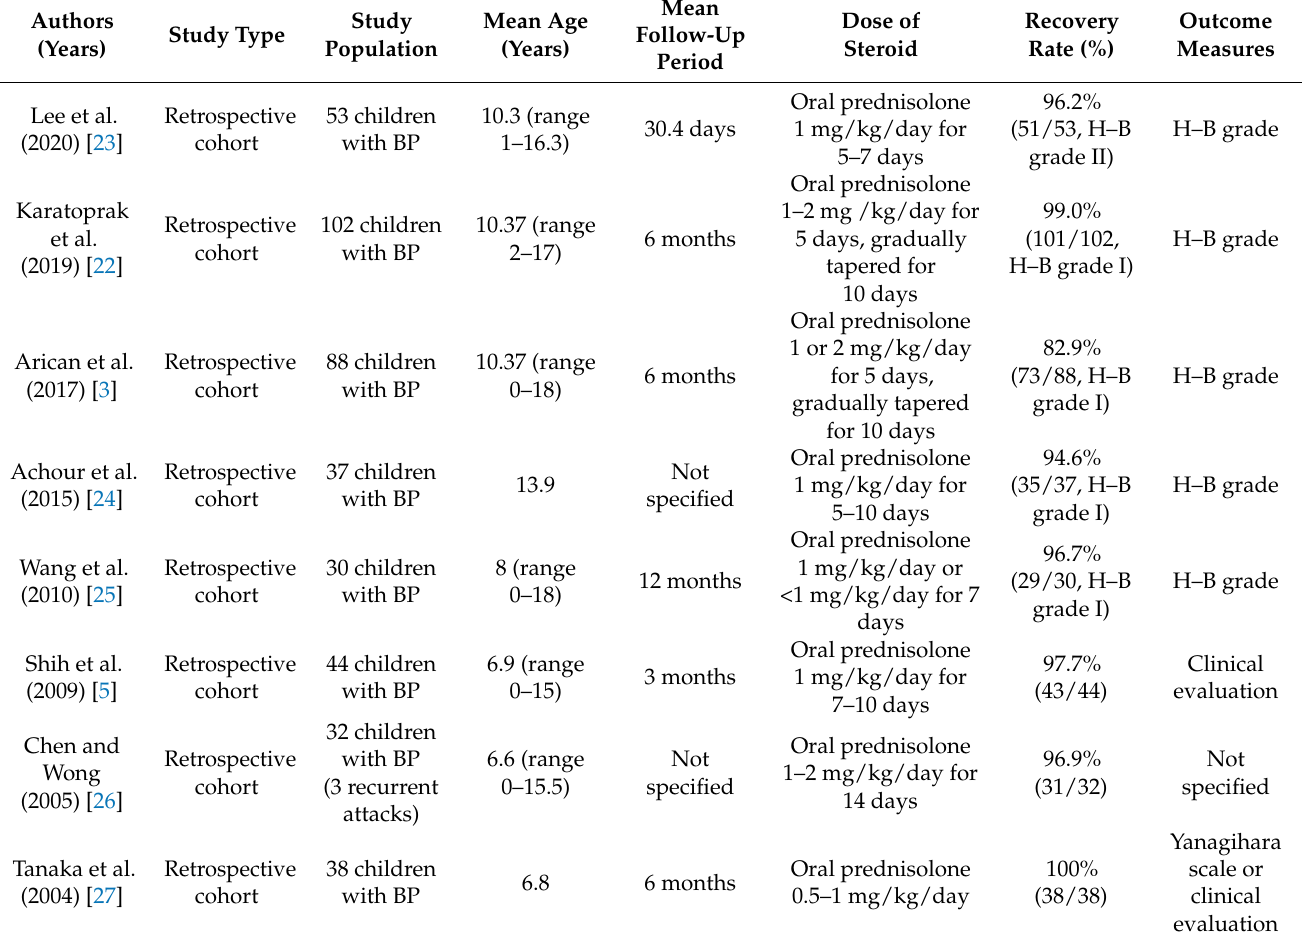
Table 4. Studies describing outcomes in pediatric Bell’s